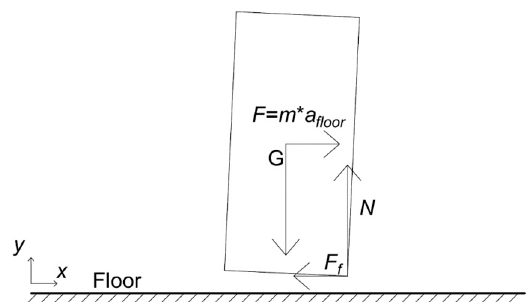
Figure 5. Physical model of movable furniture.